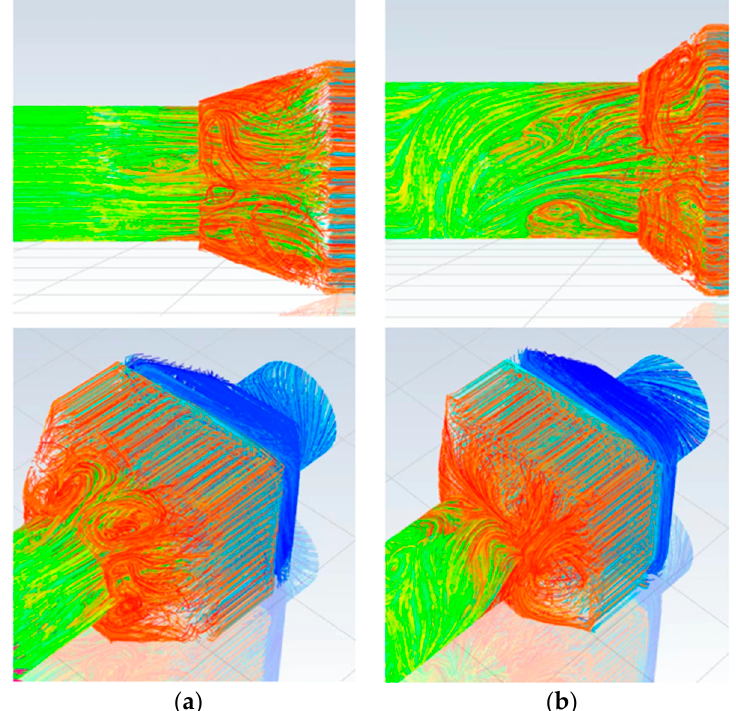
Figure 11. Path line at reactor, and diffuser with different angle: ( a ) 25°, ( b ) 40°.